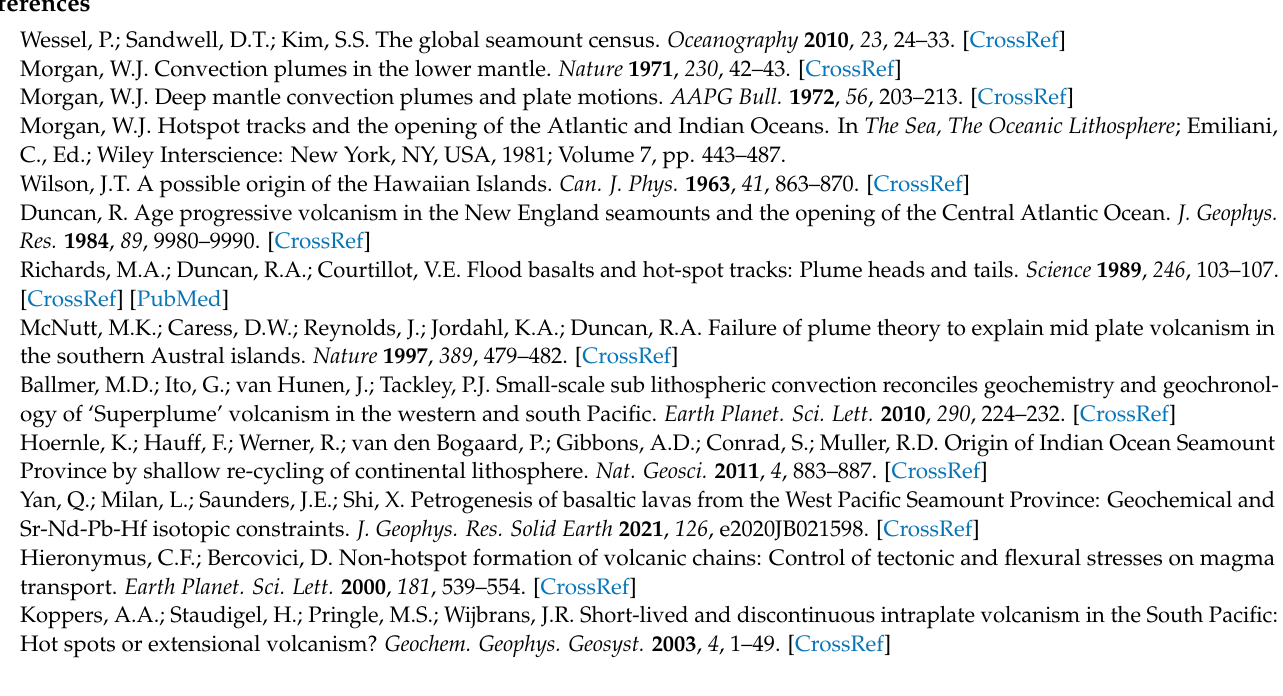
sea-level curve of [216], Table S4: Olivine and Clinopyroxene mineral chemistry from Christmas Island volcanic rocks, Figure S5: Pillow lavas ( A ) and hyloclastite breccia and broken pillows ( B ) of the Pliocene-aged Upper Volcanic Series—exposed in the Egeria Point Peninsula of Christmas Island, Table S5: Geochemistry of volcanic rocks from Christmas Island, Figure S6: Bathymetric map of the area Southwest of Christmas Island showing the location of dredge stations during voyage FR9_87 of the RV Franklin, Table S6: Mass balance and Petrolog3 modelling results for Christmas Island lavas, Figure S7: A comparison of trace element abundances in Christmas Island lava series as determined by XRF versus ICPMS/INAA methods, Figure S8: The CHRISP volcanism displays a large range in isotopic composition, Figure S9: The 187 Os/ 188 Os values of the Christmas Island lava series versus ( a ) Re (ppt) and ( b ) Re/Os values, Figure S10: The Ce/Pb ( a ) and Nb/U ( b ) versus 187 Os/ 188 Os values for the Christmas Island lava series, Figure S11: Pressure (GPa) and temperature ( ◦ C) for parental petit-spot magmas from the Hokkaido Rise, northwestern Pacific, Figure S12: Ce/Pb vs Eu/Eu* values of the Christmas Island lava